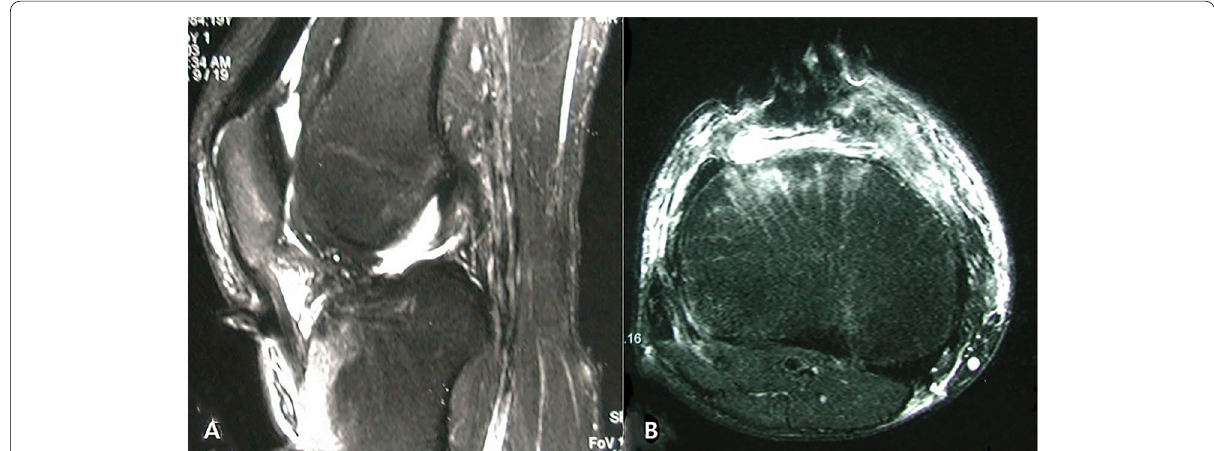
Fig. 1. Initial T2‑weighted MRI images showing patellar tendon rupture observed as defect on the distal part. a Sagittal image. b Axial